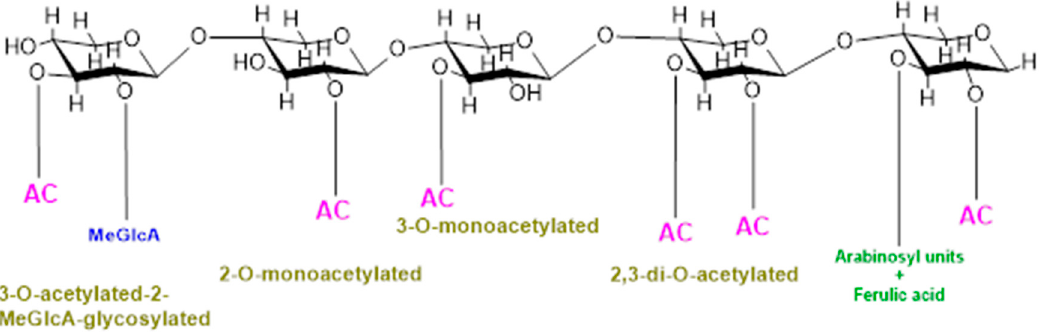
Figure 1. Types of xylan acetylation in woody plants and grasses.